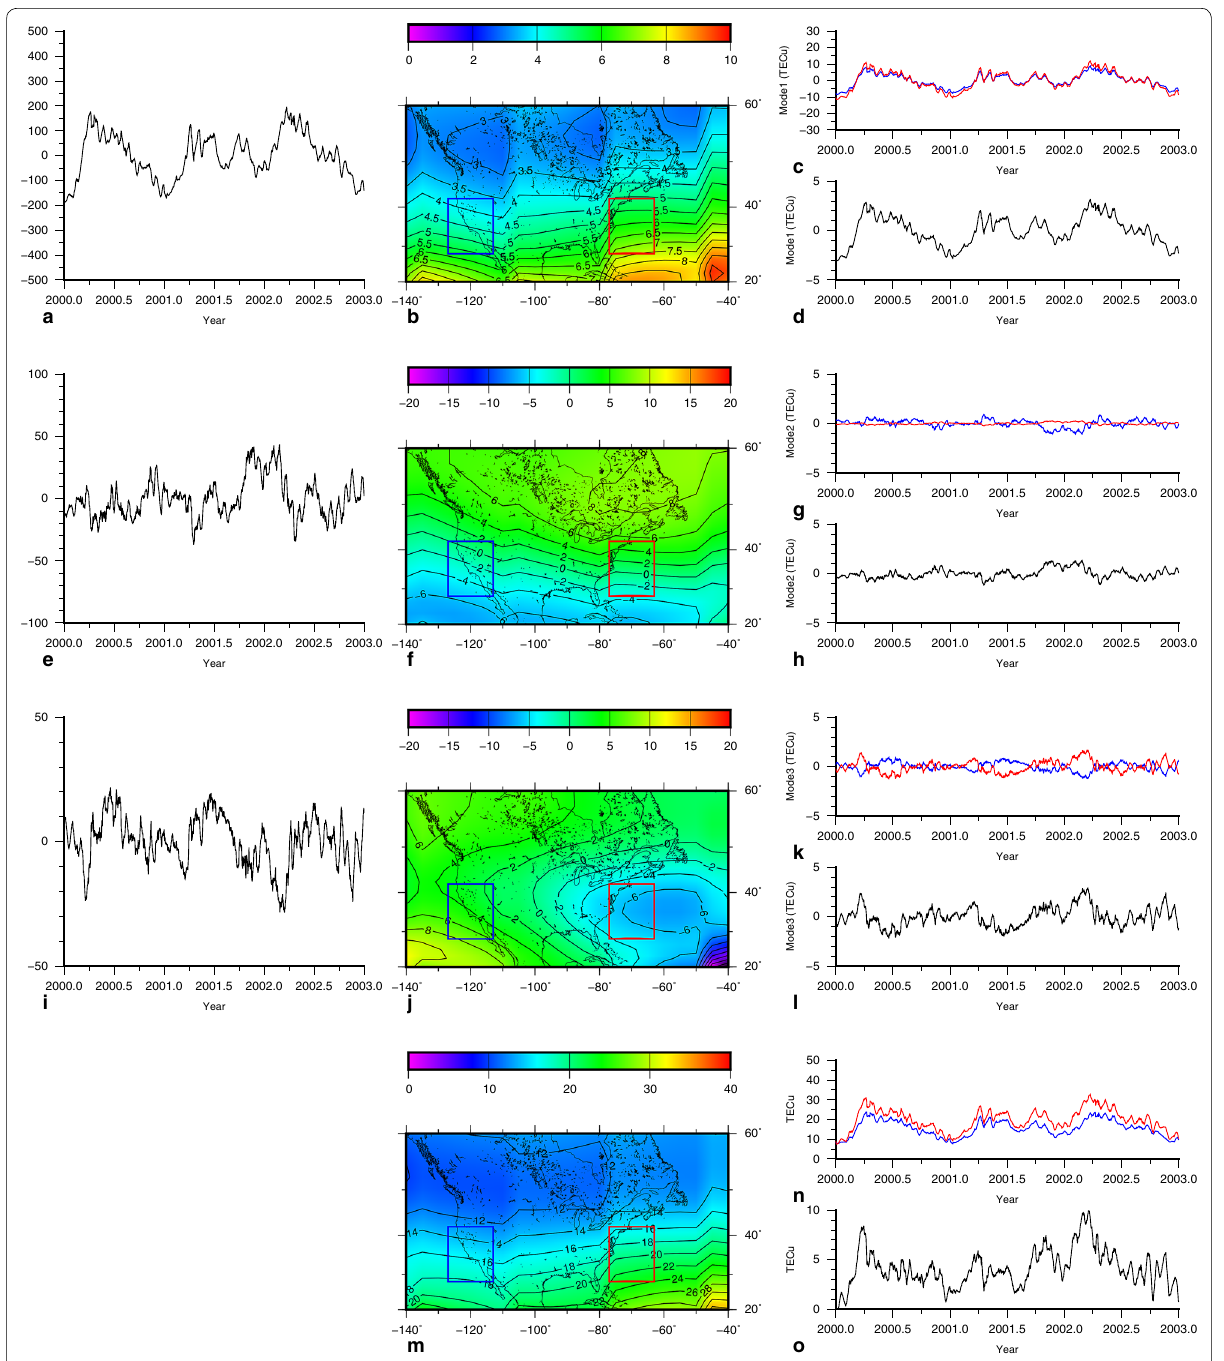
Fig. 3 vTEC GNSS over the North American region: a amplitude of the temporal variation, a 1 (the y -axis has to be multiplied by a factor of 10 − 2 ), b eigenvector or spatial variation, e 1 , c synthesized data for mode 1 ( a 1 e 1T ) for red (east) and blue (west) rectangles, d difference between red and blue · curves of c , e the amplitude of the temporal variation, a 2 (the y -axis has to be multiplied by a factor of 10 − 2 ), f eigenvector or spatial variation, e 2 , g synthesized data for mode 2 ( a 2 e 2T ) for red (east) and blue (west) rectangles, h difference between red and blue curves of g , i the amplitude of the · temporal variation, a 3 (the y -axis has to be multiplied by a factor of 10 − 2 ), j eigenvector or spatial variation, e 3 , k synthesized data for mode 3 ( a 3 e 3T ) · for red (east) and blue (west) rectangles, and l difference between red and blue curves of k . Finally, the time-averaged vTEC GNSS ( x ) ( m ), the synthe- sized data, n vTEC ∗ GNSS ( t ) , for red (east) and blue (west) rectangles, and the difference ( dvTEC ∗ GNSS ( t ) ) between red and blue curves of n ( o